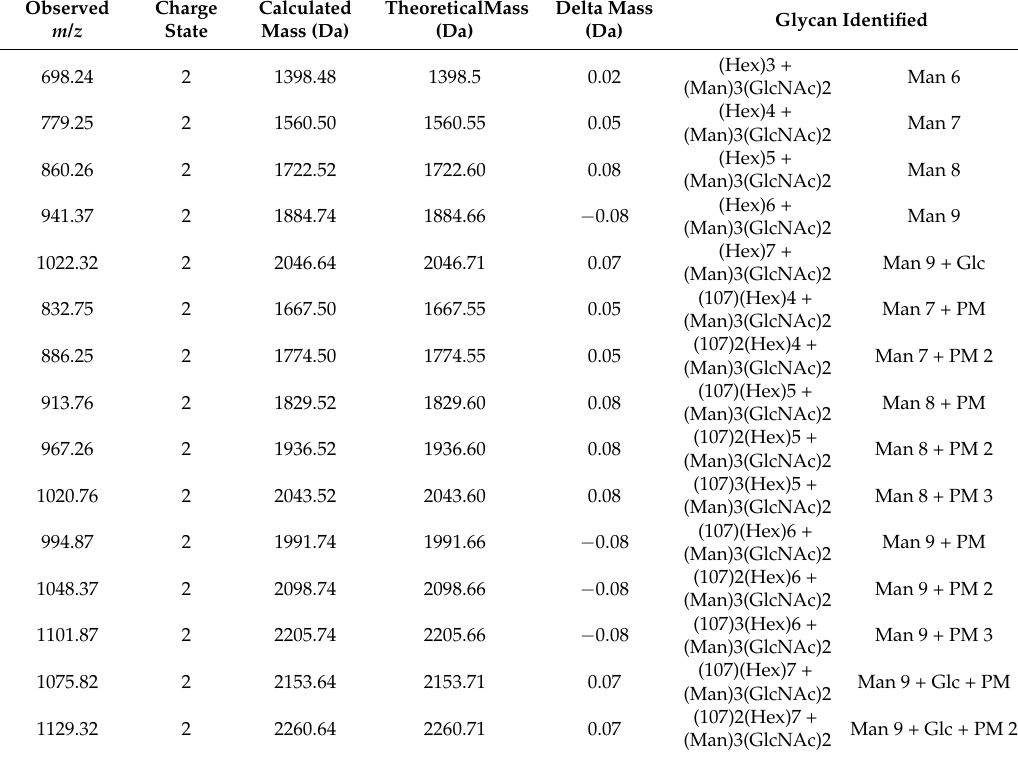
Table 1. N -glycans identified in Euglena by